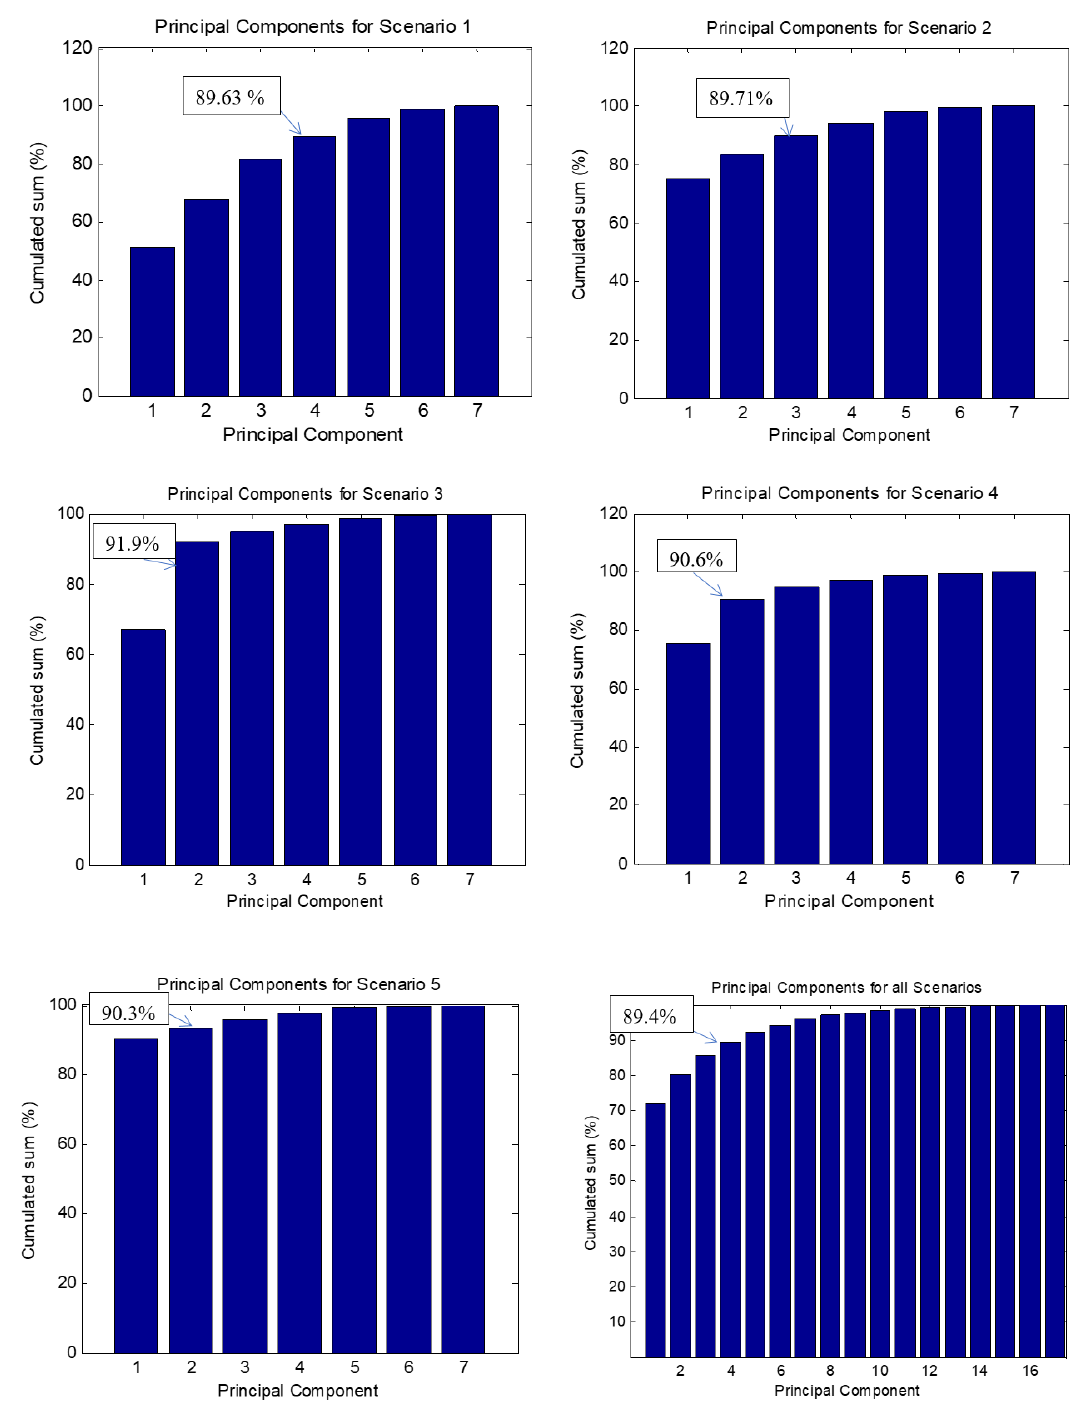
Figure 8. From left to right: the cumulated sum associated to principal components for each scenario (1 to 5) and for overall scenarios. Only PCs with cumulated sum greater than 89% are